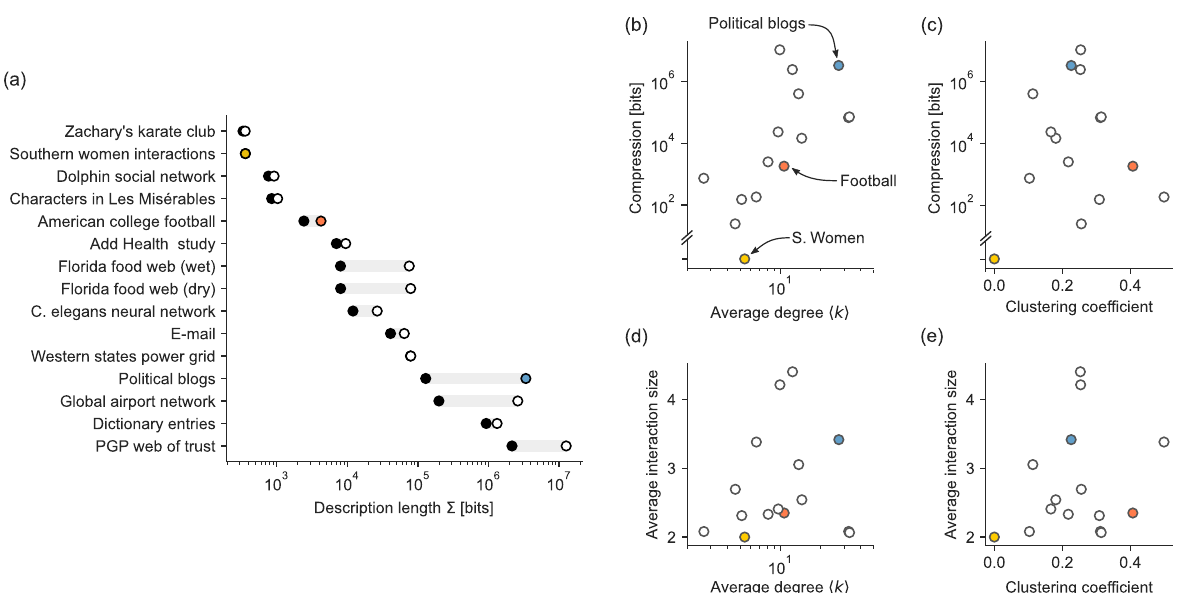
Fig. 7 Higher-order interaction in empirical networks. A few datasets are highlighted with colors: the Southern women interaction data 53 (yellow), the Football data 51 (orange), and the political blogs 54 (blue). a Description length of the hypergraph H whose hyperedges are the maximal cliques of the input network G , compared with the description length found with our method. b , c Compression, de fi ned as the difference in description length, as a function of the average degree and clustering coef fi cient 2 . d , e Interaction size, averaged over all interactions in H *, as a function of the average degree and clustering coef fi cient. Detailed numerical results are reported in Supplementary Table